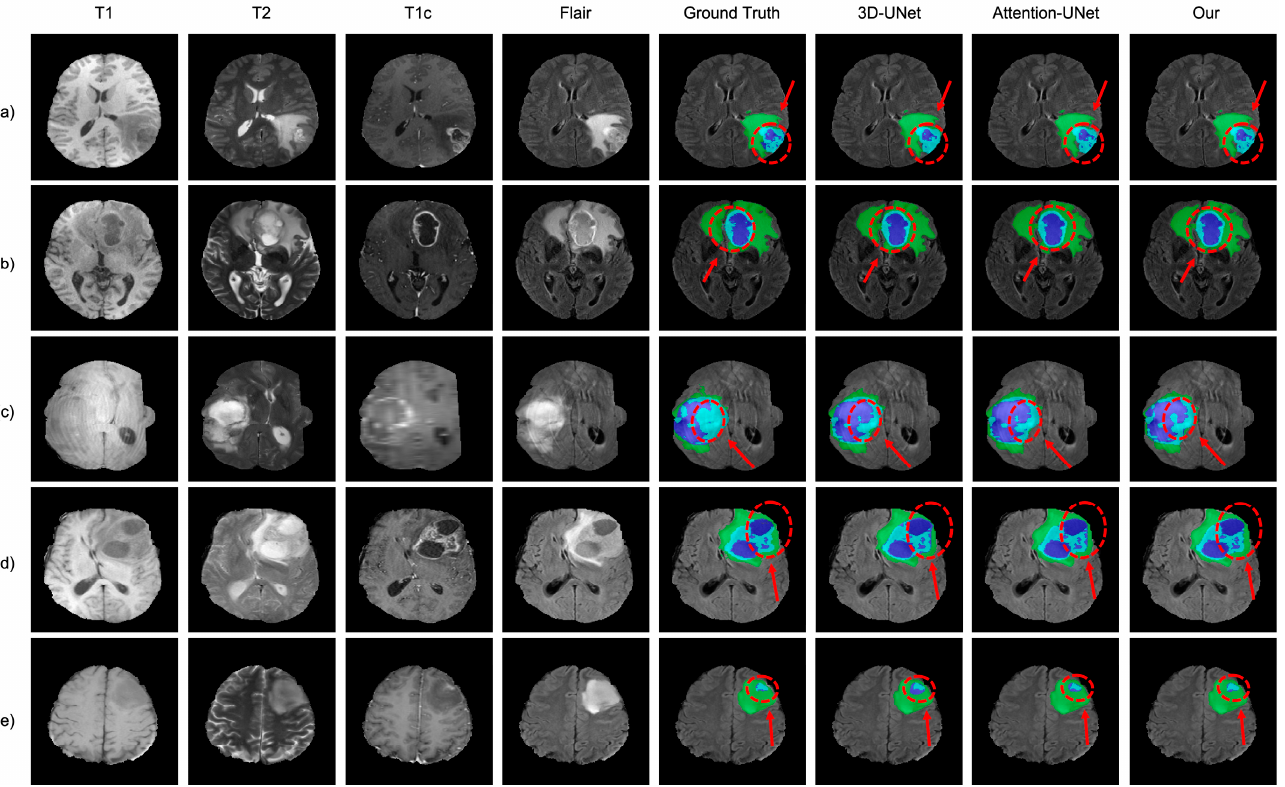
Figure 4. The visualized segmentation results of the proposed AABTS-Net and other methods. ( a – e ) represents different visualized cases. From left to right: T1, T2, T1c, Flair, Ground truth, the result segmented by 3D-UNet, the result segmented by Attention-UNet, and the result segmented by our model.